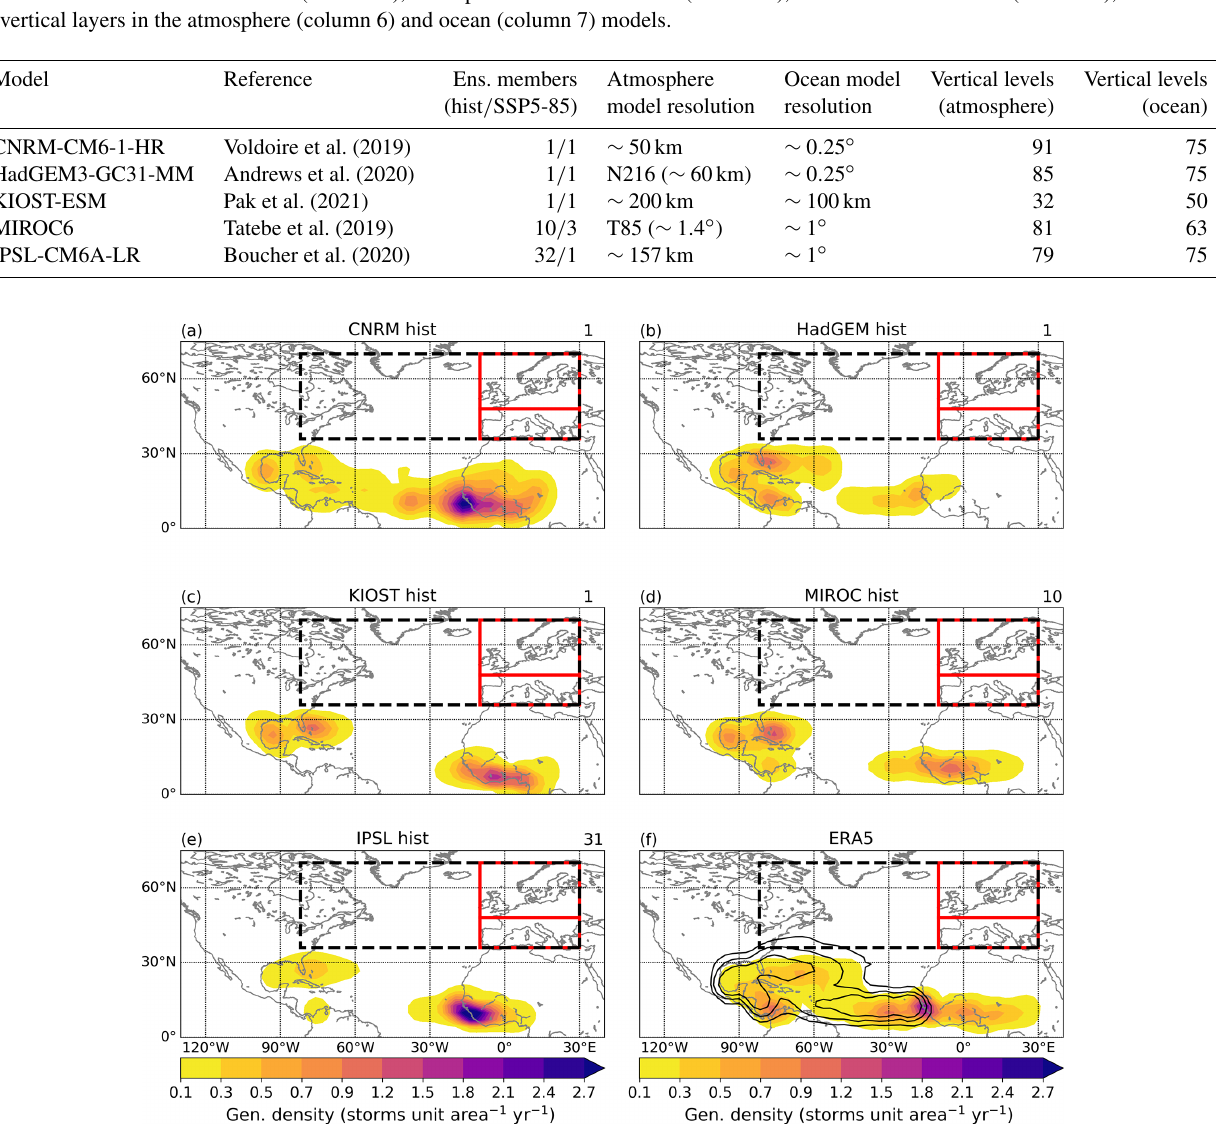
Figure 1. Genesis density (storms per unit area per year, where the unit area is equal to a spherical cap with a 5 ◦ radius) for the 1984–2014 period from the historical runs of five CMIP6 models (a–e) , and ERA5 (filled) and HURDAT2 (black lines, f ). Only TCs forming during the North Atlantic hurricane season are considered. The number of ensemble members used is shown in the top right of each panel. Densities of less than 0.1 have been masked for clarity. HURDAT2 contours in panel (f) are 0.1, 0.3, 0.5, and 0.7 storms per unit area per year, where the unit area is equal to a spherical cap of 5 ◦ radius. The black dashed region represents the recurvature domain, red regions represent the northern Europe (top), southern Europe (bottom) and Europe (whole red region)